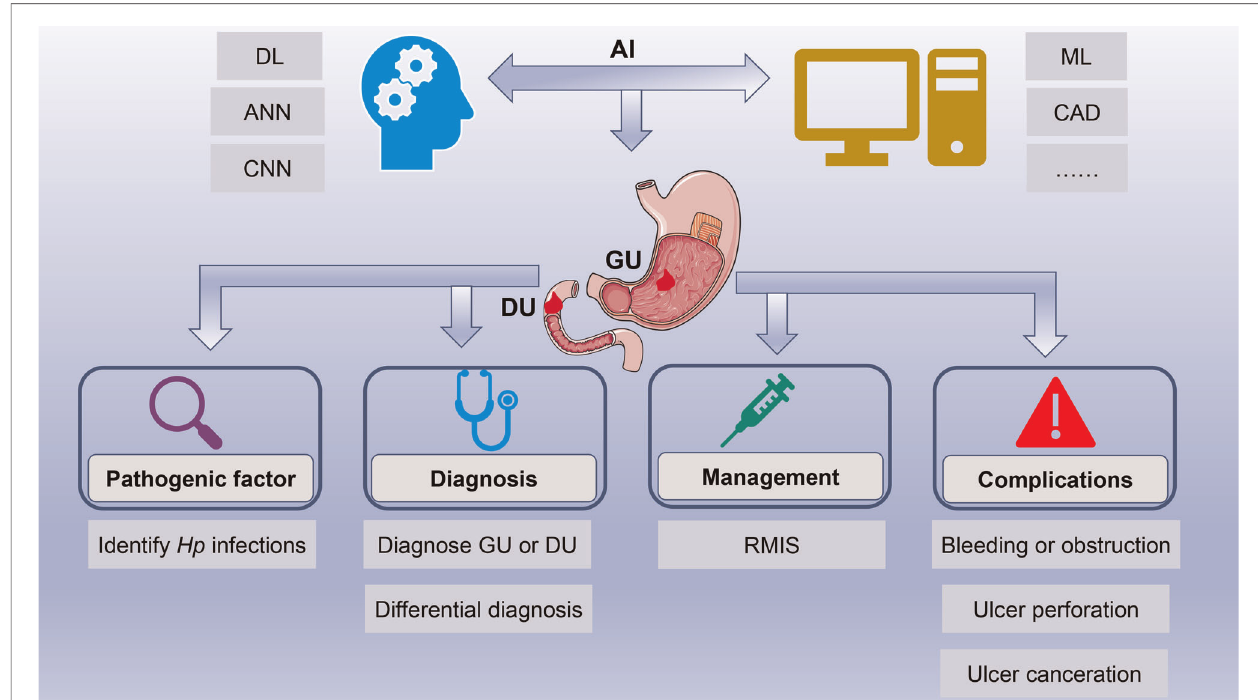
FIGURE 1 | Application of arti fi cial intelligence in peptic ulcers. AI has achieved rapid development in the fi eld of PU with the help of technological innovations such as ML, DL, and CNN. AI is widely applied in the fi eld of PU, ranging from its pathogenic factors, diagnosis and differential diagnosis to management and complications. Abbreviations: AI, arti fi cial intelligence; PU, peptic ulcer; ML, machine learning; DL, deep learning; CNN, convolutional neural